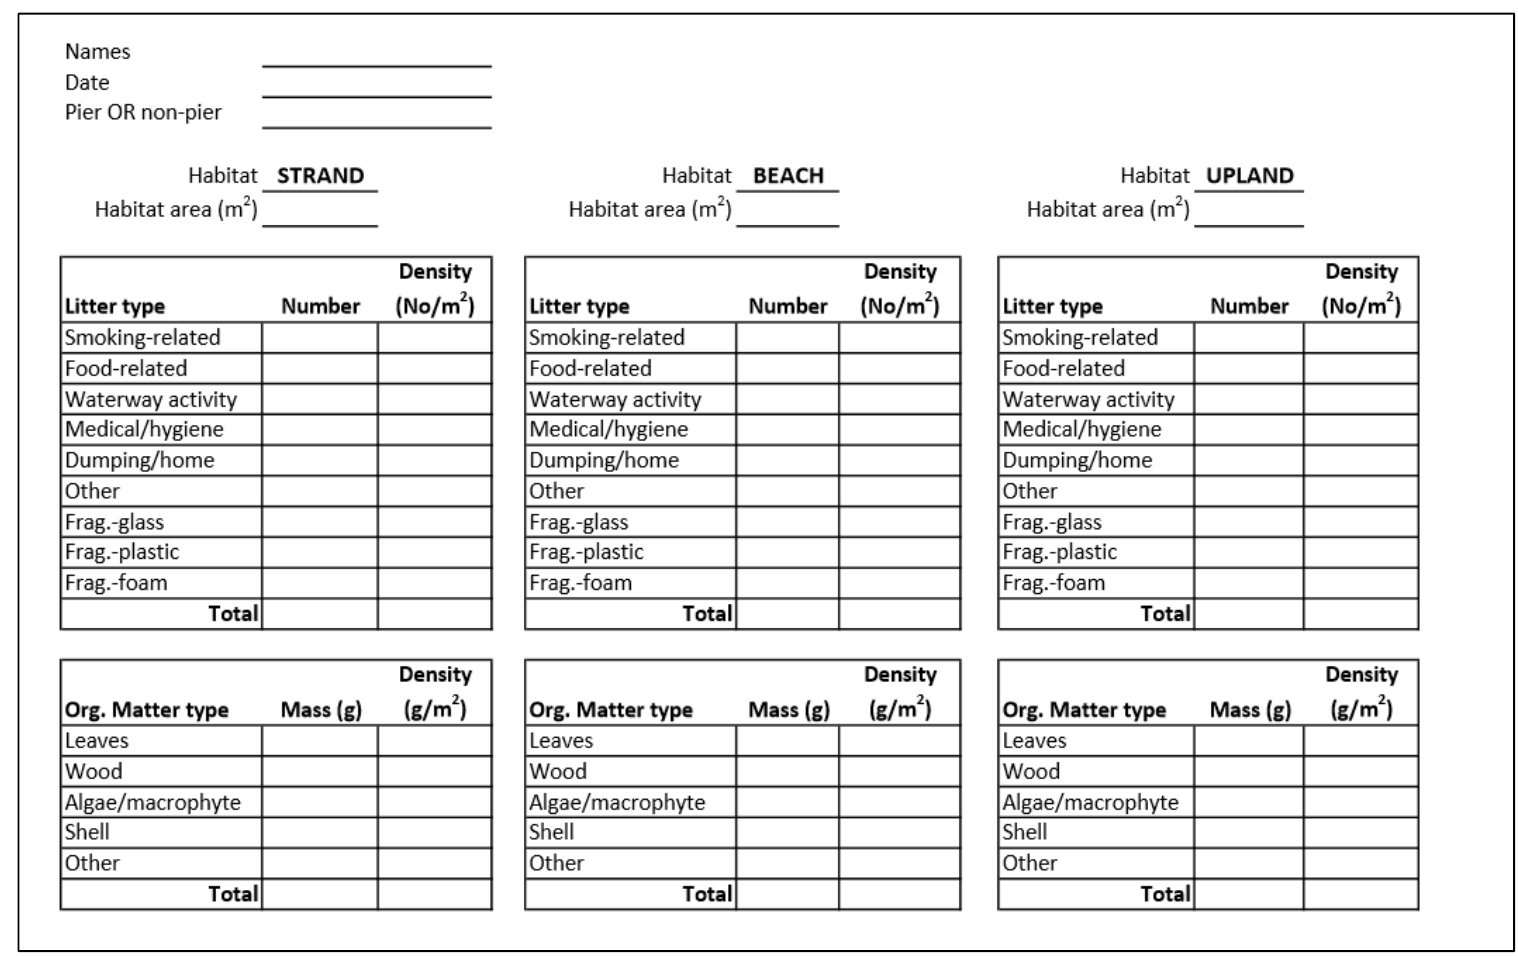
Figure A2. Datasheet for collection of anthropogenic litter (AL) and coarse particulate organic matter (CPOM). Frag. = fragment.